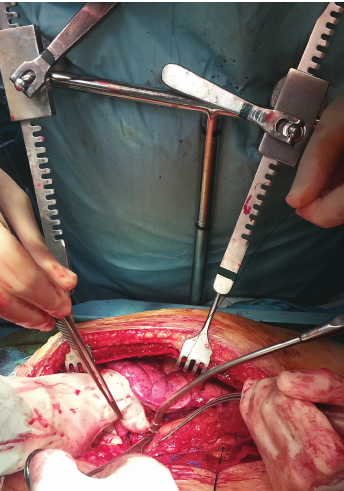
Figure 1: Intraoperative photo depicting the utility of T-bar in accessing left upper